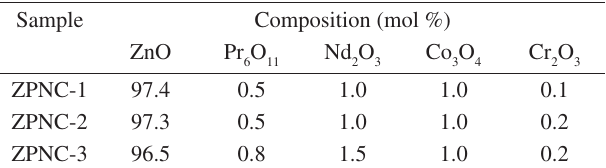
Table 1. Composition of investigated samples of the ZPNC system. Sample